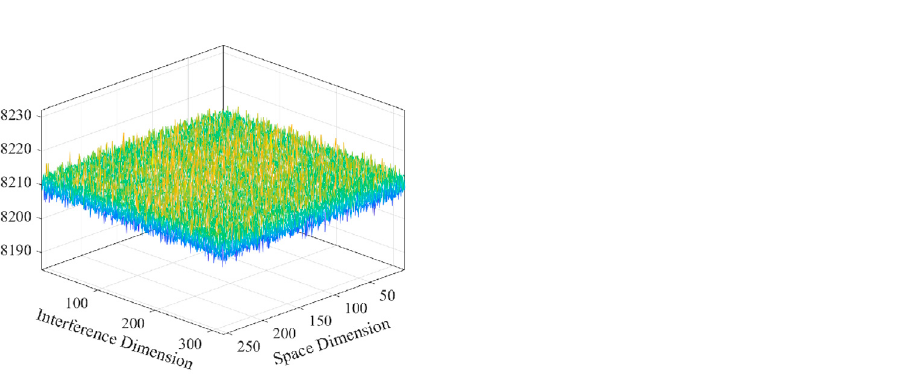
( b ) Figure 11. ( a ) Two-dimensional interferogram of 338 K radiation source. ( b ) Three-dimensional surface of the interferogram. It can be seen that the interference fringes had obvious rotation, the baseline is greatly distorted, and the response uniformity of the pixels of the same interference order is poor. The relative radiation response calibration was performed using the row-by-row FFT- IFFT method proposed in Section 4.1. Since there were two pixels on an interference order